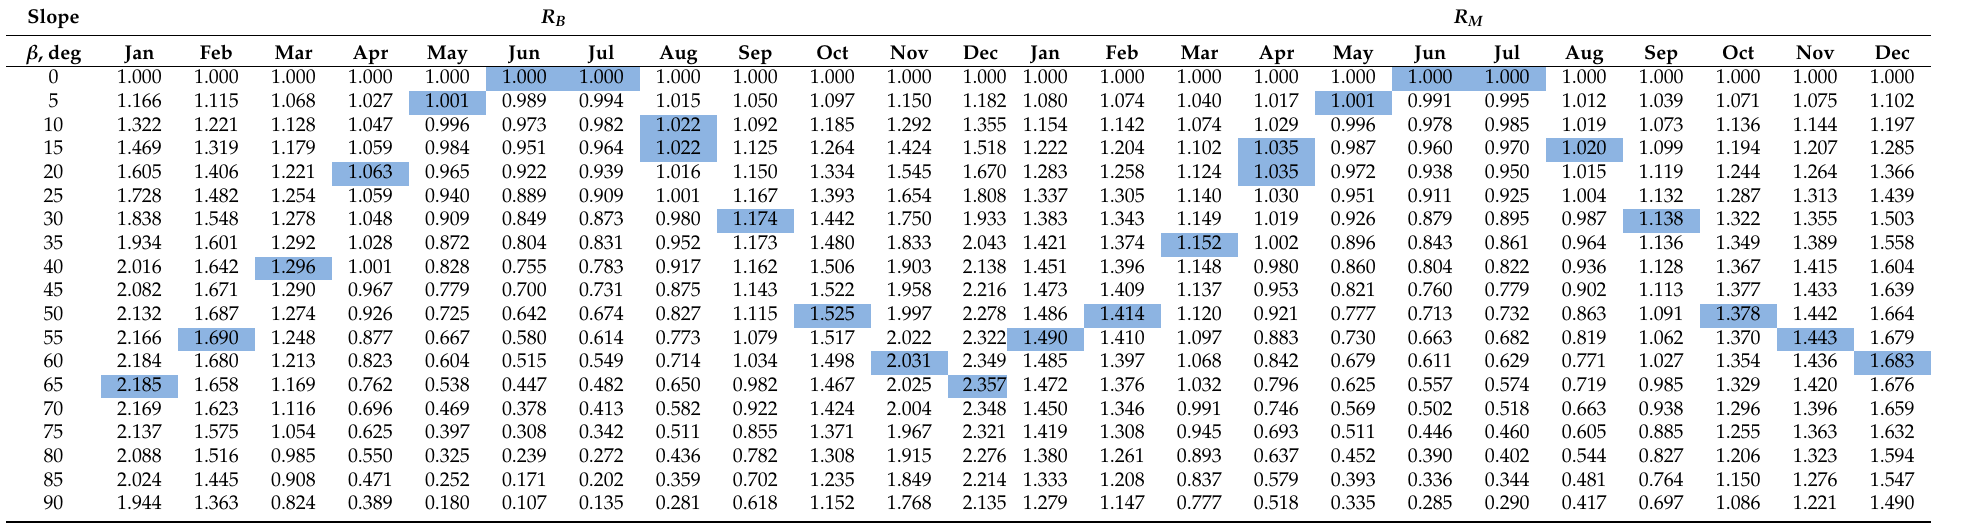
Table 14. R B and R M conversion factors for each month of the year for different slope angles ( β ) at Athalassa. The optimum slope angles for each month are